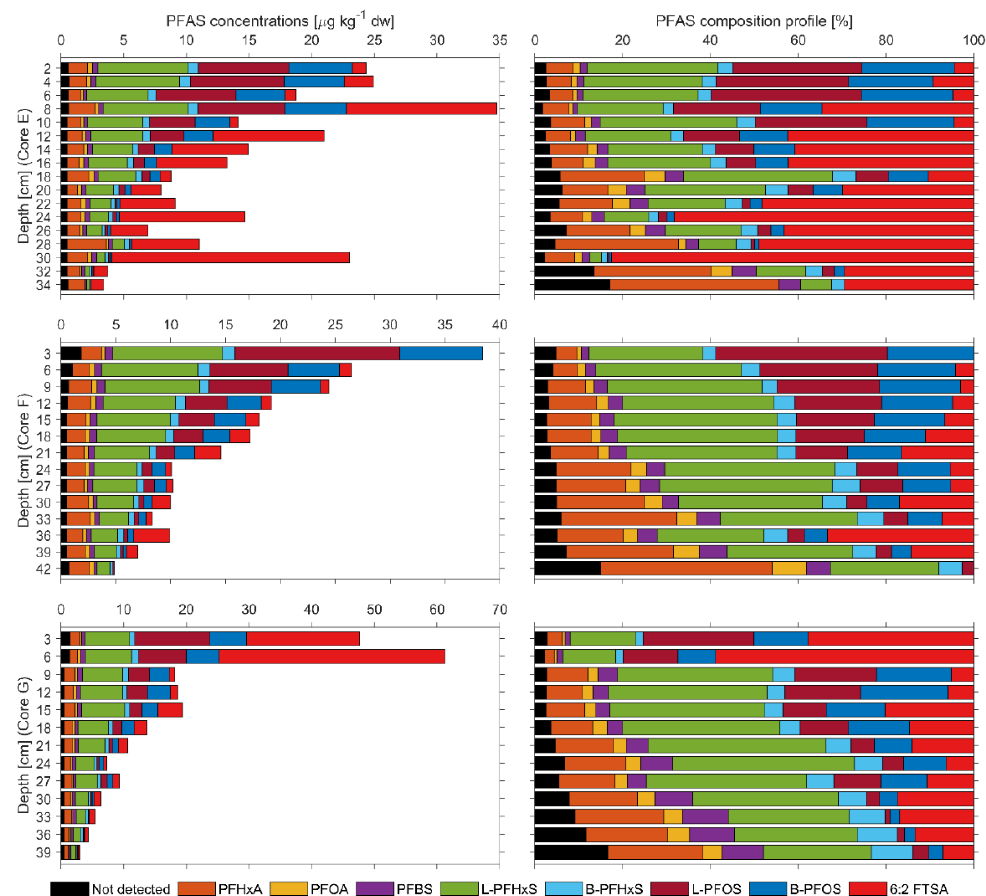
Figure 2. PFAS concentration ( µ g kg − 1 dw) and relative composition profile of lake sediment Cores E–G; “not detected” includes concentrations of PFHpA, PFNA, PFDA, PFUnDA, PFDoDa, MeFOSAA, EtFOSAA and 0.5 MDL for the undetected PFAS.